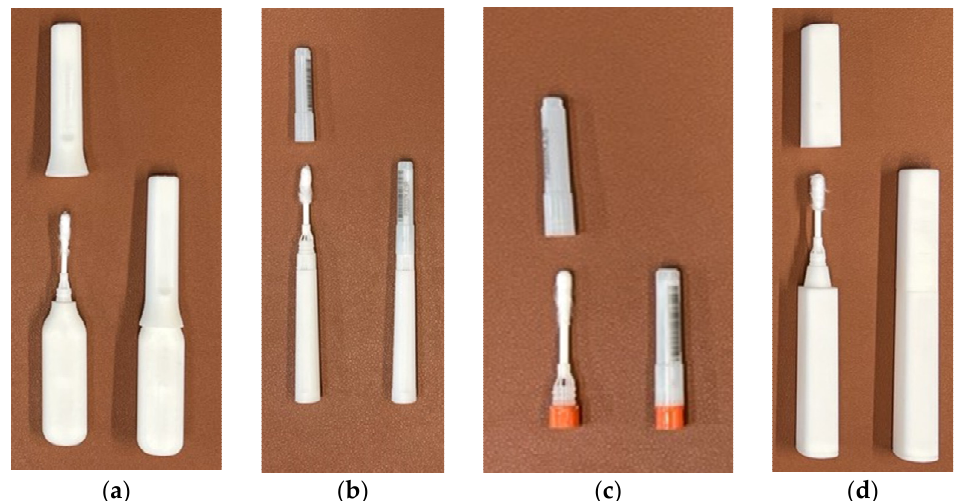
Figure 2. Prototype concepts: ( a ) key twist concept; ( b ) elongated concept; ( c ) colored cap concept; ( d ) marker concept.